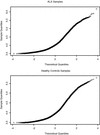
Correlation between genes in the healthy controls in ALS (y-axis) and CAD (x-axis) studies, showing the Lowess smoothing line in red.